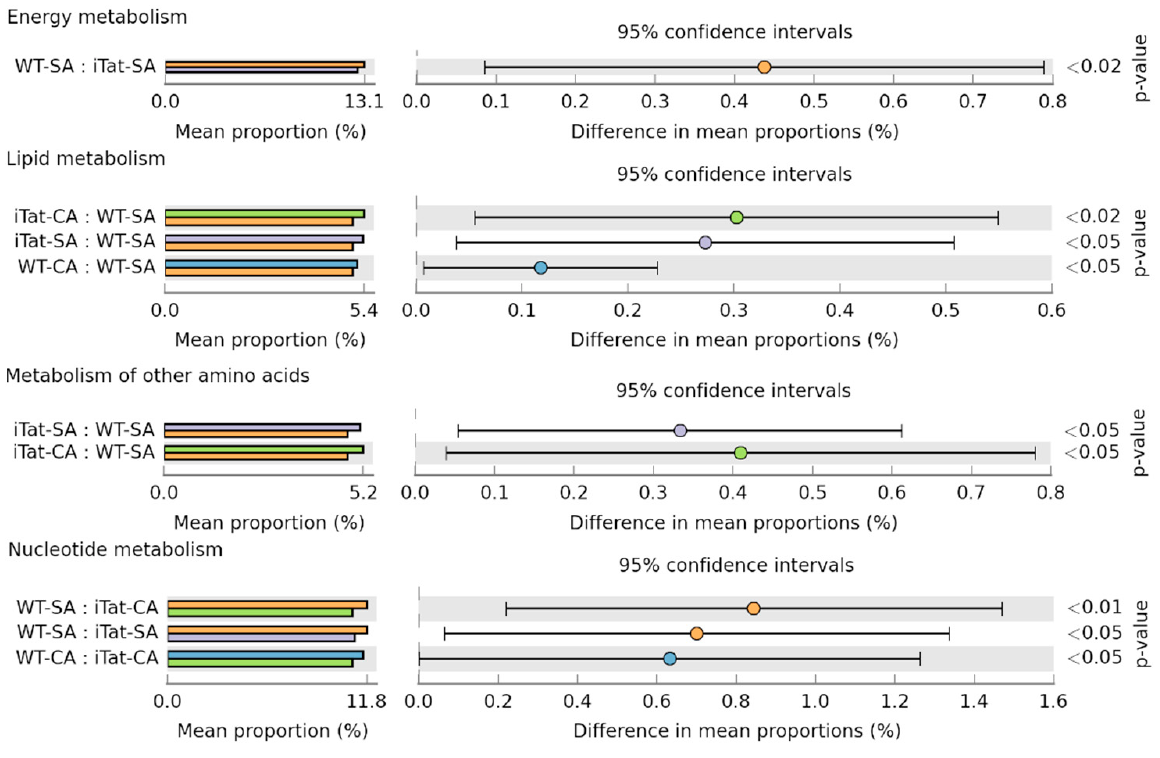
Figure 9. Effects of Tat expression and cocaine exposure on the metabolism in the gut of 12-month female mice. The Tax4Fun were used to estimate the changes of metabolic functions of the gut microbiota. Only significant changes of the metabolism pathways were detected in the gut of 12-month female mice and presented using Kruskal–Wallis test, followed by post hoc Games–Howell’s test.